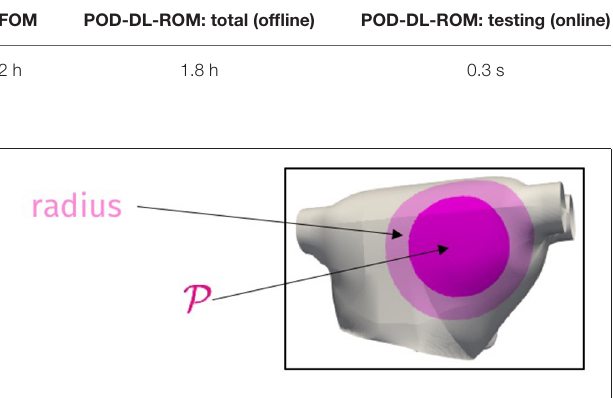
TABLE 2 | Test 1.2 : FOM and POD-DL-ROM computational times.